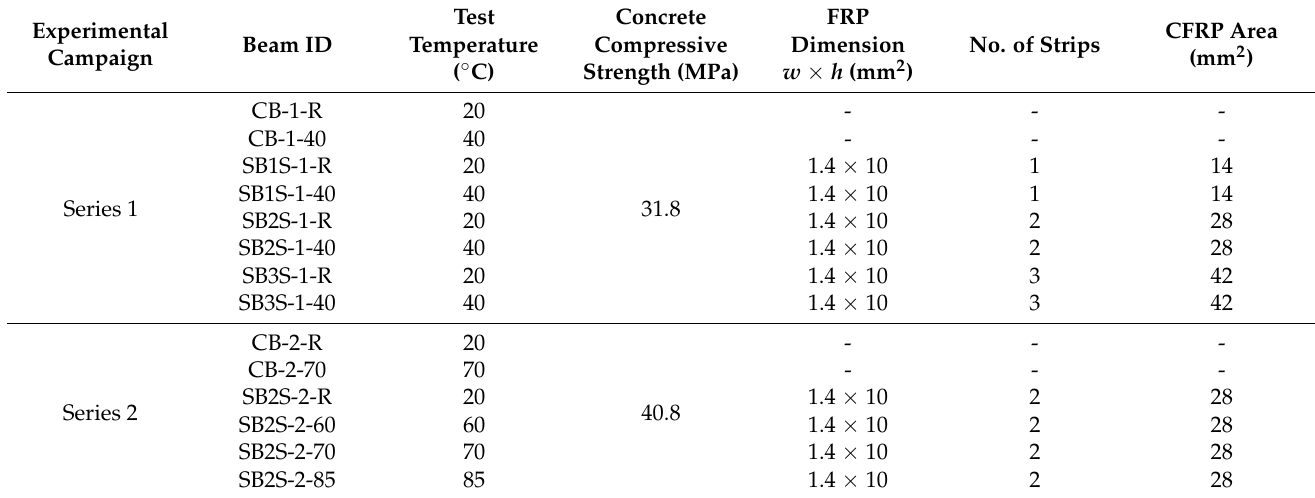
Table 1. Details of the tested